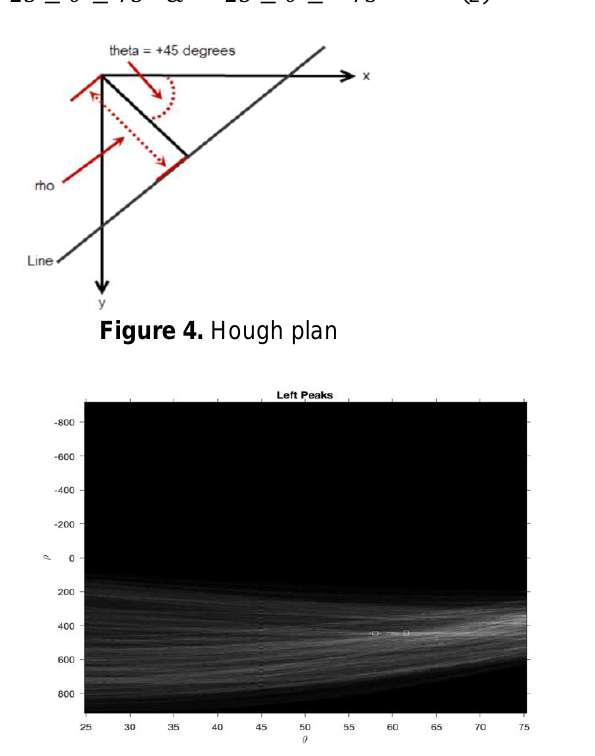
Figure 5. Peaks in the Hough plane from the left side of the road